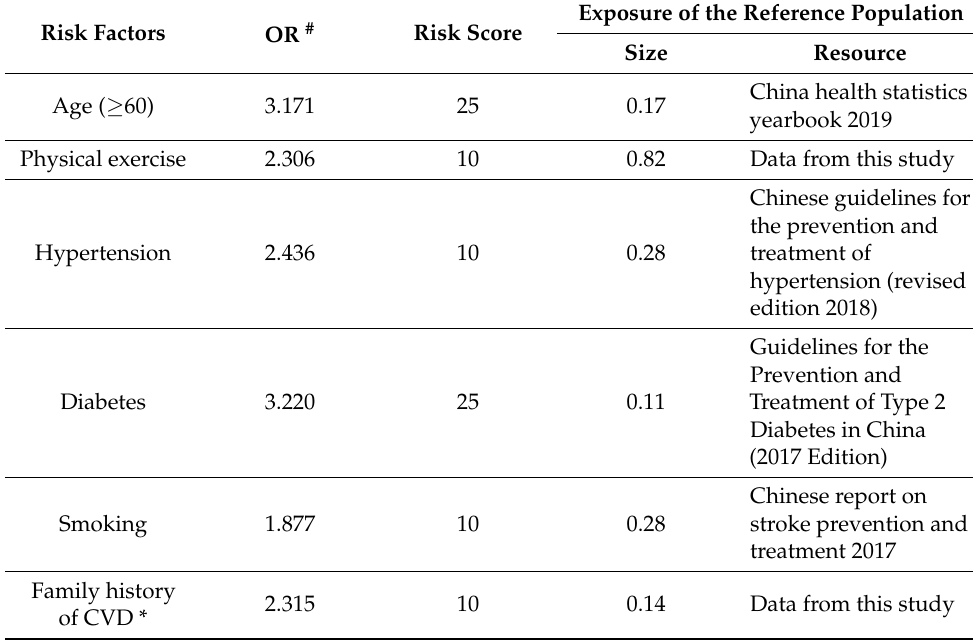
Table 5. Development of the risk score of cerebrovascular disease.